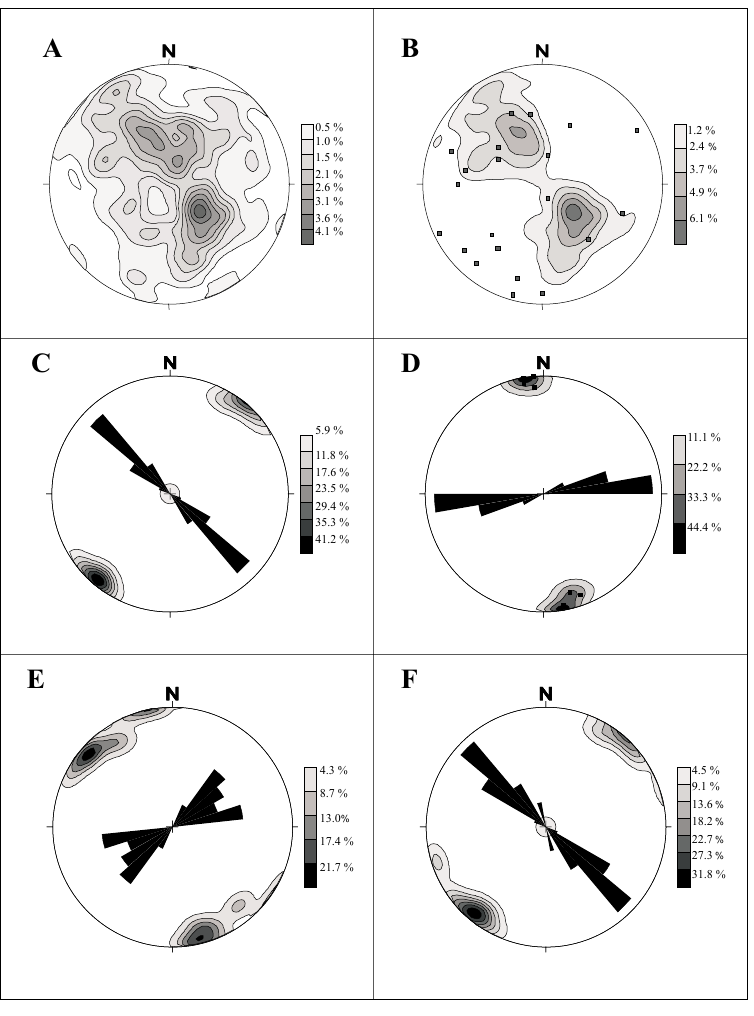
Fig. 3 – Stereographic diagrams representing the polar projections of the foliations of the study area: A) General foliation poles of the area (Sg and Sm), of NE/SW NS and NW/SE directions. Number of foliation measurements: 388; Maximum: 310/40, 156/40 and 200/37. B) Foliation poles Sg and Sm and mineral lineation (filled squares) of the Cláudio Shear Zone domain. Number of foliation measurements: 246; Maximum: 310/40 and 155/40. Number of lineation measurements: 21. C) Poles to foliation of dextral S b1 (Shear bands) of NW/SE direction. Number of foliation measurements: 27; Maximum: 040/82; the rosette represents the foliation direction. D) Poles to foliation of sinistral S b1 (Shear bands) of E-W direction. Number of foliation measurements: 22; Maximum: 130/82 and 344/83; the rosette represents the plane direction. E) Poles to foliation of sinistral S b2 (Shear bands) of ENE/WSW direction. Number of foliation measurements:17 ; Maximum: 218/88and040/85. F)PolestofoliationofdextralS b2 (Shearbands)ofNW/SEdirection. Number of foliation measurements: 9; Maximum: 170/83 and 350/85.